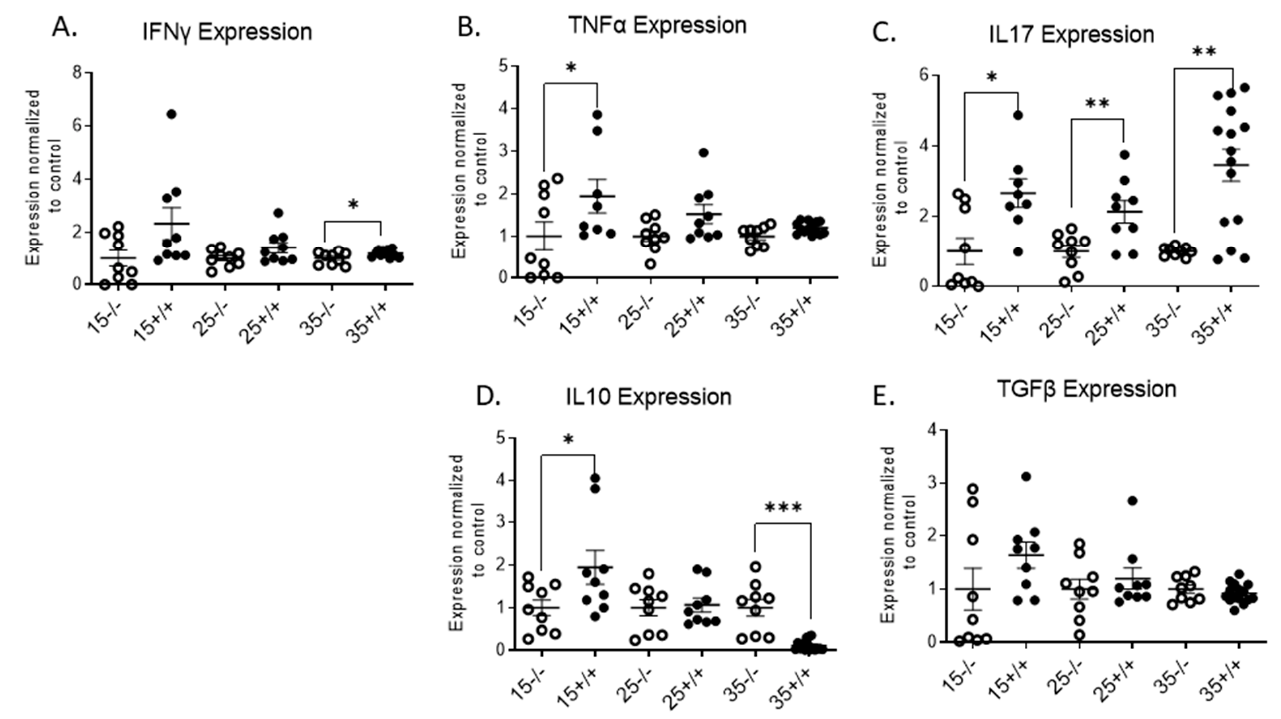
Figure 4. qRT-PCR analysis of BL/6 and BL/6-CD3FLAGmIR mice islet mRNA expression of IFN γ , TNF α , IL-17, IL-10, and TGF β . IFN γ ( A ), TNF α ( B ), IL-17 ( C ), IL-10 ( D ), and TGF β ( E ) islet mRNA expression at 15 weeks ( n = 3 mice with 3 replicates), 25 weeks ( n = 3 mice with 3 replicates) and 35 weeks ( n = 4 mice with 3 replicates) of age. − / − indicates BL/6 mice and +/+ indicates BL/6-CD3FLAGmIR mice. Both BL/6 and BL/6-CD3FLAGmIR results are compared to the control, beta-globin, a housekeeping gene. Unpaired student t test: * p ≤ 0.05, ** p ≤ 0.01, *** p <